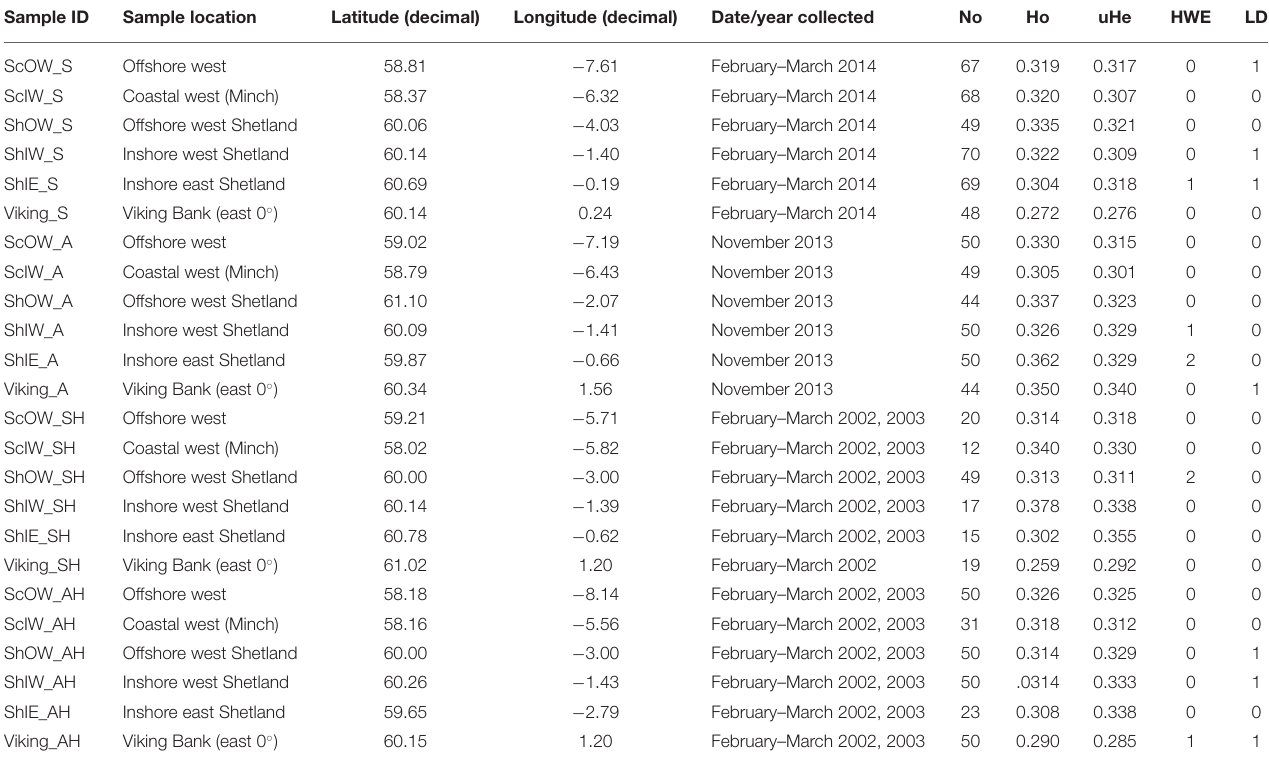
TABLE 1 | Overview of sample origin, and summary of population specific SNP marker ( n = 13) performance listing unbias observed (Ho) and expected (uHe) heterozygosity, as well as the number of markers which deviate from Hardy-Weinberg equilibrium (HWE) or Linkage Disequilibrium (LD). Sample ID